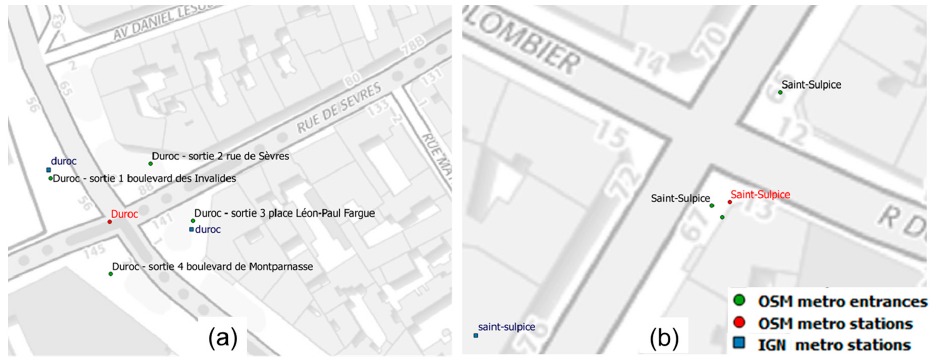
Figure 10. Different representations of a subway station: ( a ) the two station POI in IGN are closer to